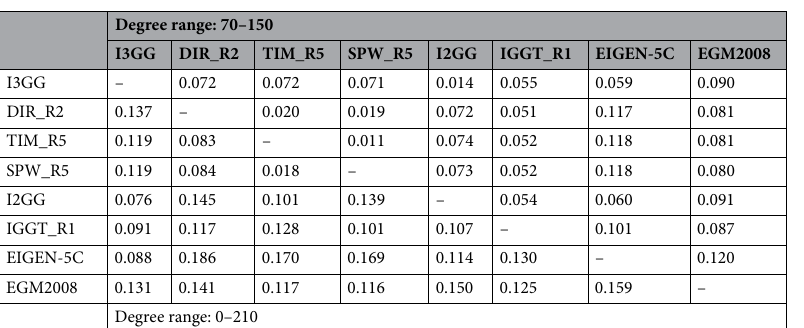
Table 1. RMS values of geoid differences (unit: m) between in the eight models (I3GG, DIR_R2, TIM_R5, SPW_R5, I2GG, IGGT_R1, EIGEN-5C and EGM2008) for the common degree range of the models, i.e. 0–210 (lower triangle) and for the medium- frequency range 70–150 (upper triangle). The RMS values are computed 1 from 1 ◦ ◦ grids excluding the polar caps, i.e. latitude range of − ×